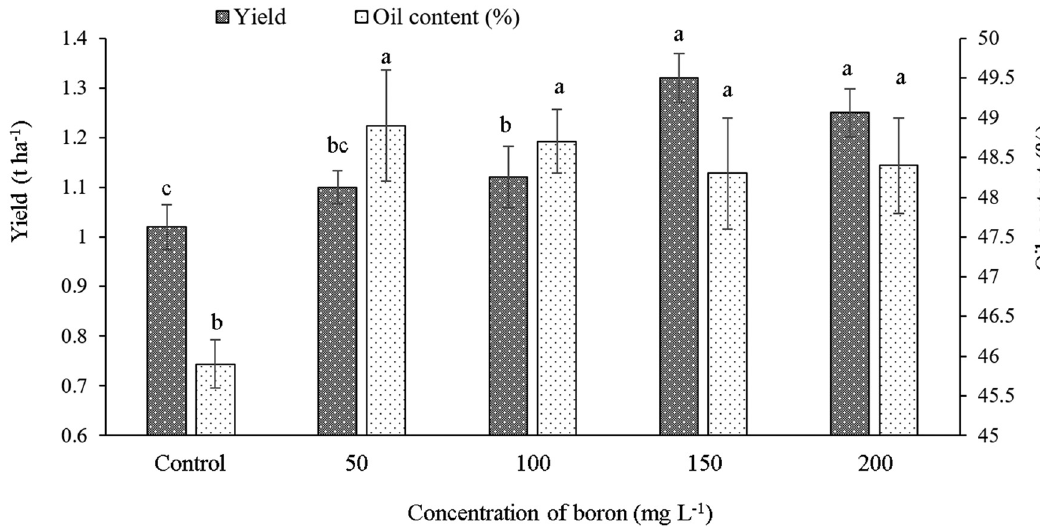
Figure 7: E ff ect of boron on yield and oil content. Letters within the columns represent a signi fi cant di ff erence ( P < 0.05 )